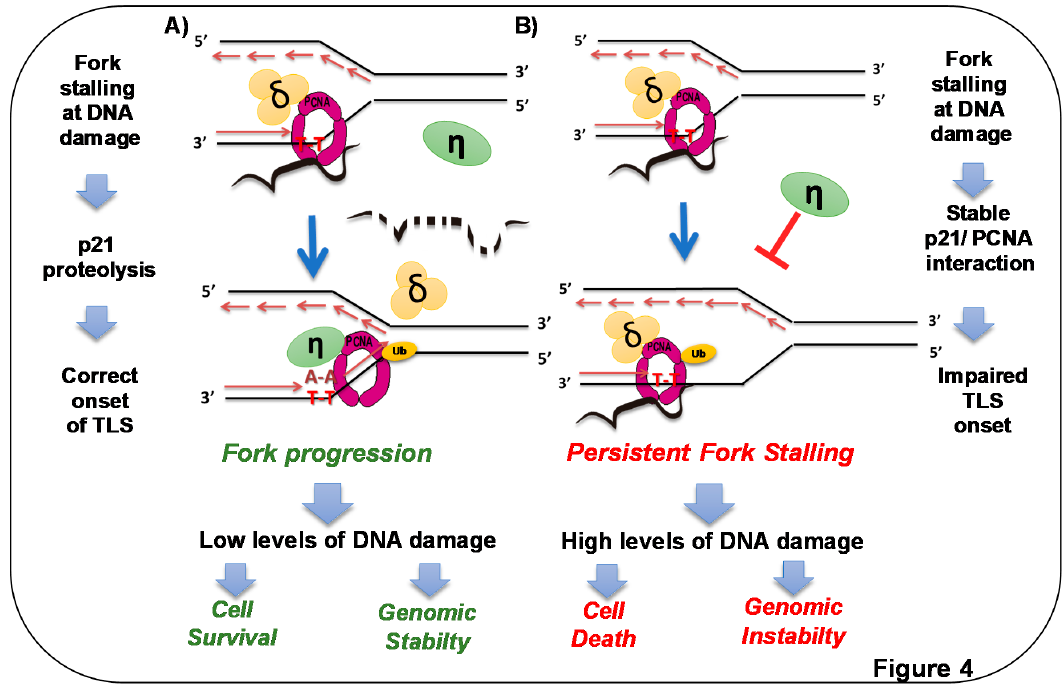
Figure 4. p21 overexpression in S phase triggers cell death by preventing DNA replication across DNA lesions. A) Endogenous p21 is degraded at sites of DNA lesions. Elimination of p21 [50] and